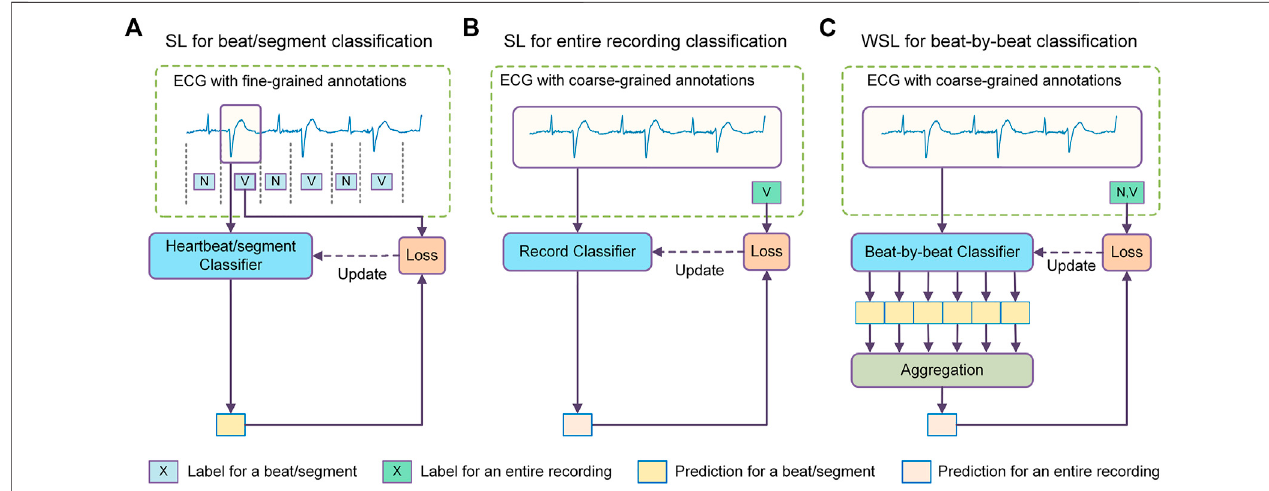
FIGURE 1 | Comparison between different methodologies of machine learning for arrhythmia detection. (A) The supervised learning (SL) method for heartbeat/segment classi fi cation which uses fi ne-grained annotations for model training and achieves fi ne-grained predictions. (B) The SL method for ECG recording classi fi cation which uses coarse-grained labels as supervision and achieves coarse-grained predictions. (C) The weakly supervised learning (WSL) method for beat-by-beat classi fi cation which uses coarse recording labels for model training but achieves fi ne-grained predictions. N = normal or bundle branch block beat. SVEB = supraventricular ectopic beat. VEB = ventricular ectopic beat.